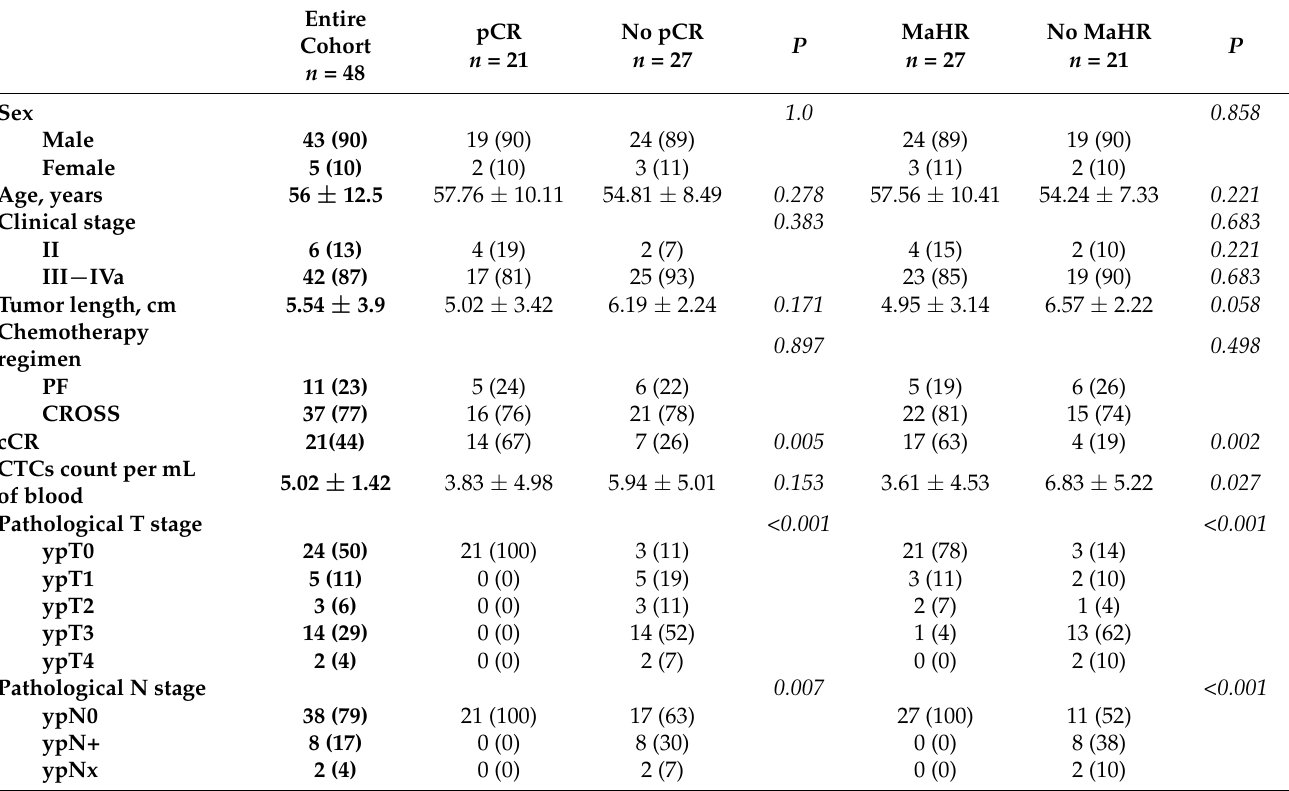
Table 1. General characteristics of the study patients. Abbreviations: pCR, pathological complete response; MaHR, major histopathological response; PF, 5-fluorouracil/cisplatin; CROSS, carbo- platin/paclitaxel; nCRT, neoadjuvant chemoradiotherapy; cCR, clinical complete response; CTCs,